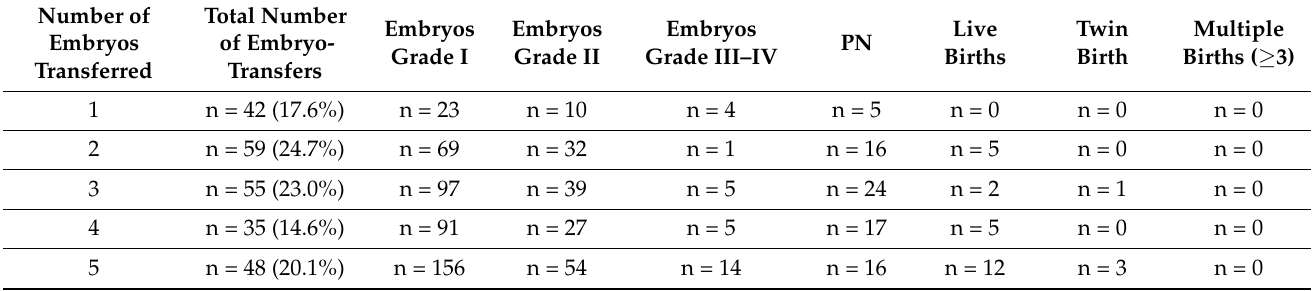
Table 3. Number and grade of embryos transferred and related success rates.